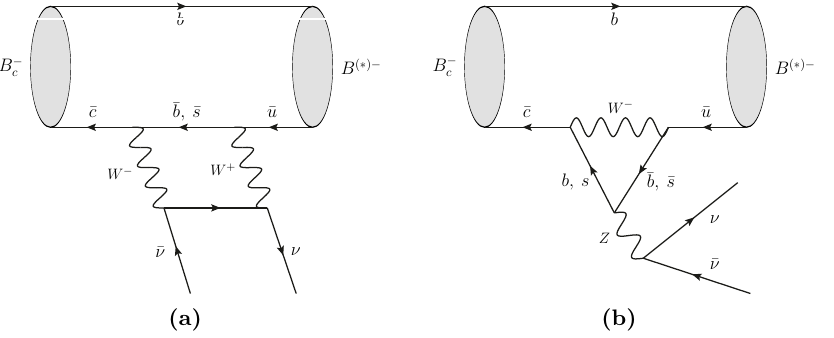
Figure 8. Feynman diagrams for the process B (cid:0) Mode Ours Ebert [33] Choi [34] Geng [35] pQCD [36]